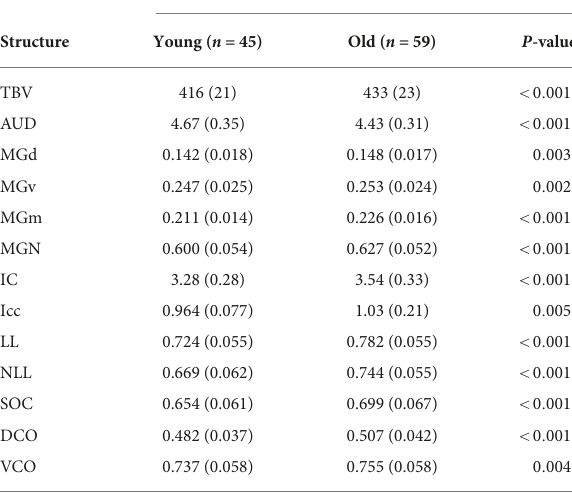
TABLE 1 Summary volumes of region of